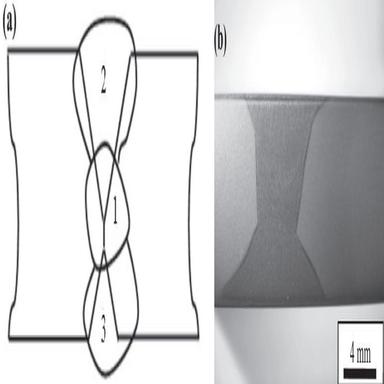
Welded joints of A6005 aluminum alloy (a) welding sequences (b) cross-section.